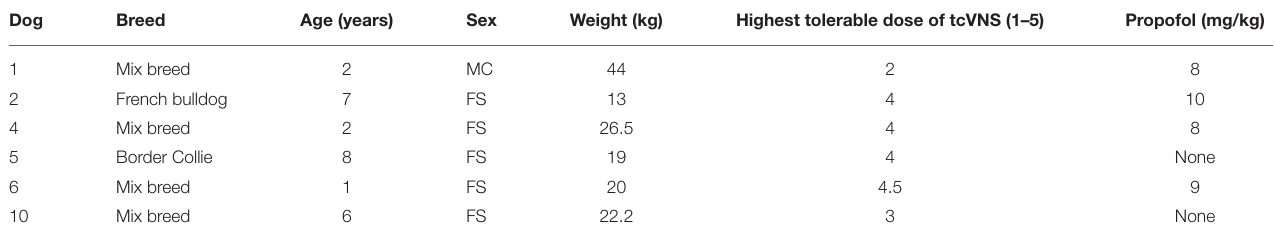
TABLE 1 | Signalment, stimulation level and amount of sedation used in the 6